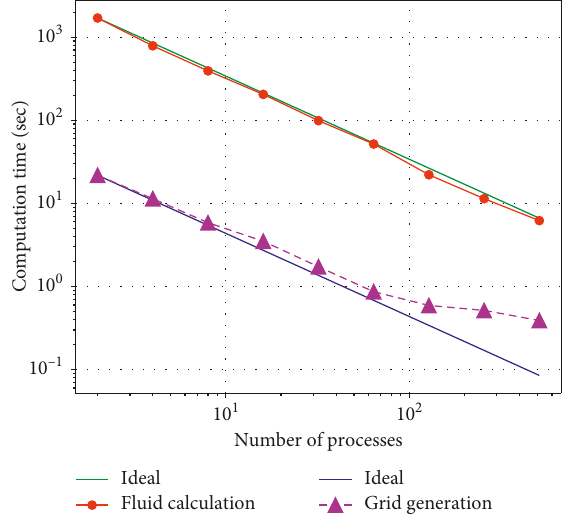
Figure 11: Performance of grid generation and fluid calculation for hybrid